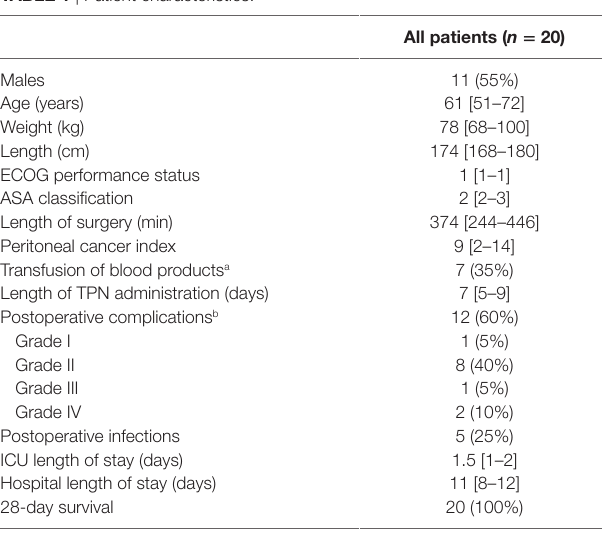
Table 1 | Patient